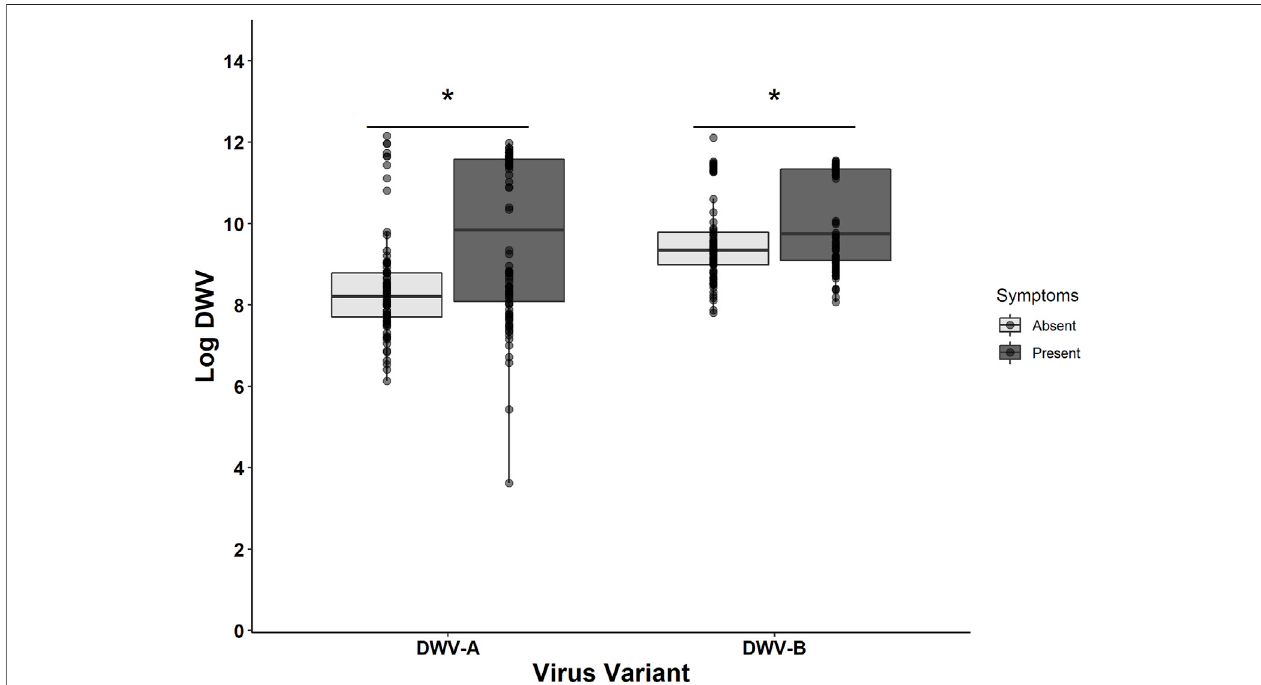
FIGURE5| DWV levelsgivensymptompresence. Thelog-transformed DWV-Aand DWV-Blevelsinheadtissuesforall sampledbees(N =180)indicate thatbees exhibitinganymorphologicalsymptomshadhigherlevelsofbothDWV-AandDWV-B.Thelightershaderepresentsasymptomaticbeesandthedarkershaderepresents symptomatic bees. Boxplots are in the style of Tukey where the box limits represent the lower 25% quantile and upper 75% quantile, with the line representing the median. * denotes signi fi cant differences between asymptomatic and symptomatic values for each DWV variant (Kruskal – Wallis test; p < 0.05). For stock-speci fi c comparisons, Supplementary Figure S3